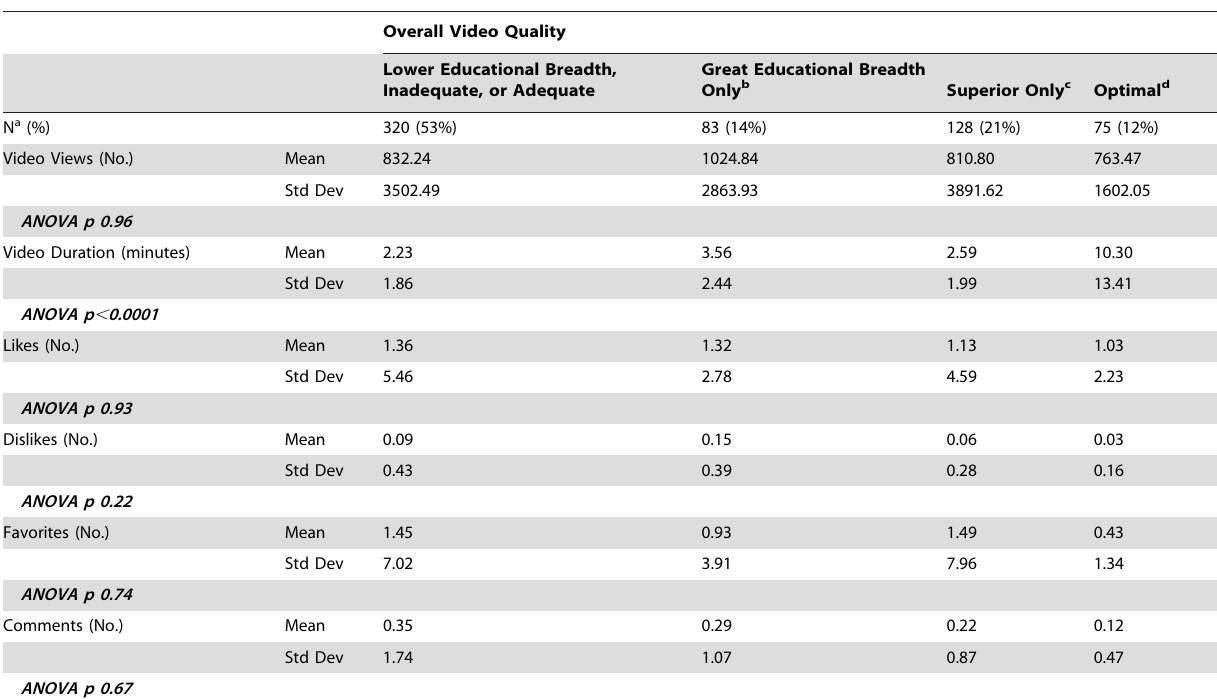
Table 4. Overall video quality based on user engagement and video duration.